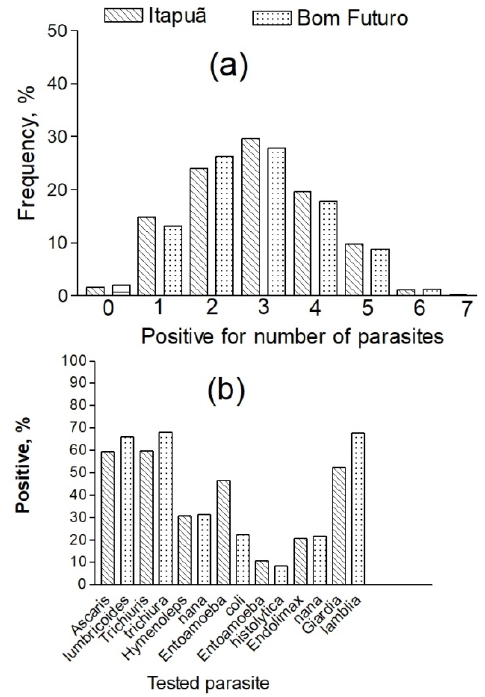
Figure 3. Illustration comparing fishermen (Itapuã) and tin miners (Bom Futuro) as a function of ( a ) frequency of children testing positive for a type of parasite; ( b ) frequency of intestinal parasites found in children.